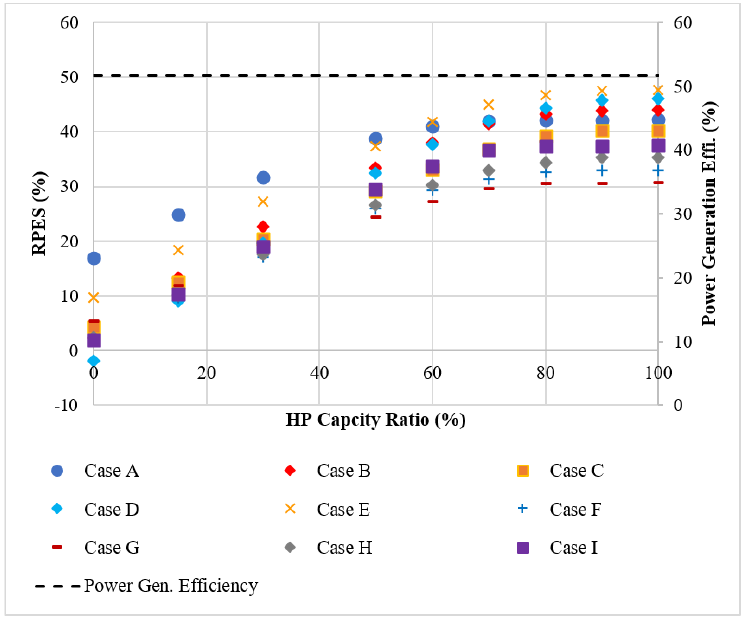
Figure 20. Change in the RPES according to the share of heat supplied by the heat